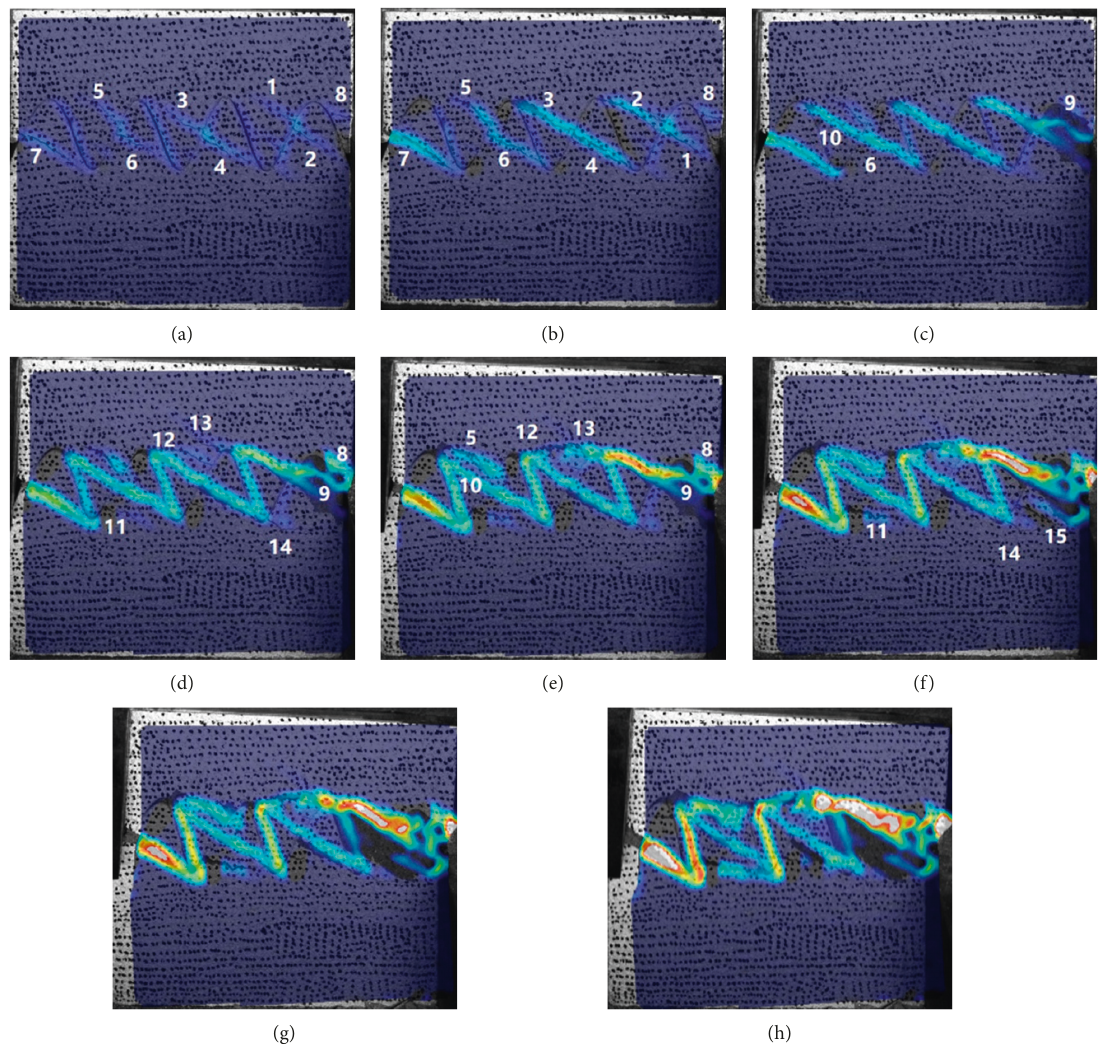
Figure 10: Failure process of the specimen with an undulated height of 20mm under DIC